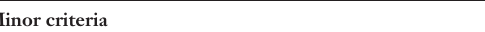
Refractory asthma ATS workshop con- sensus for typical clinical